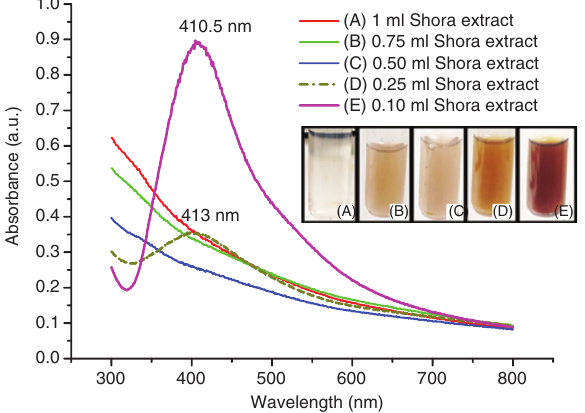
Figure 3: Visual and UV-vis absorption spectra of the synthesized silver nanoparticles (AgNps) at pH 11 with different concentration of Shora fruit